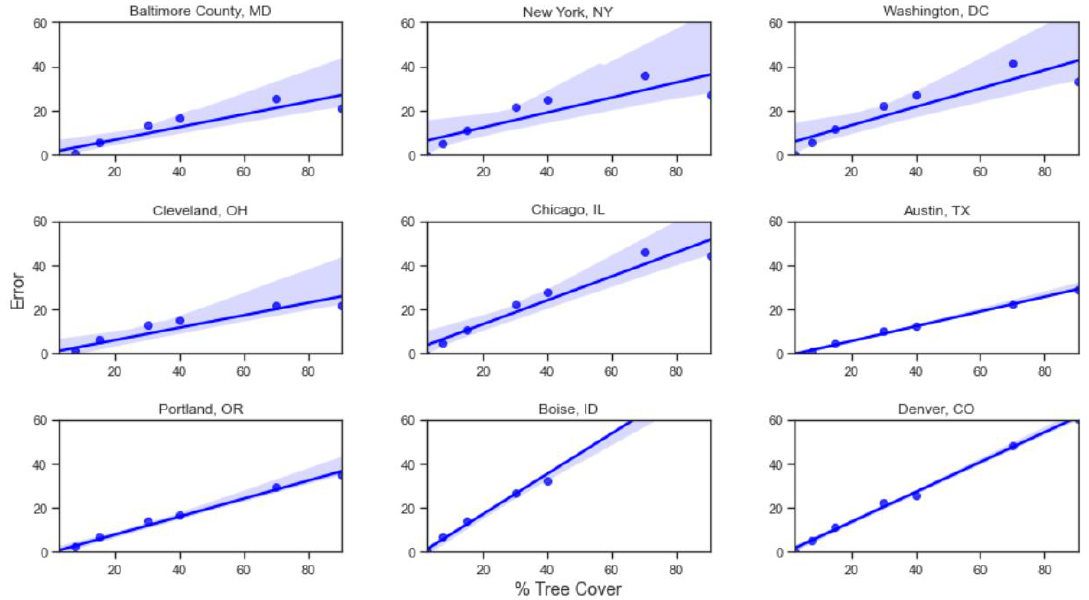
Figure 6. Variations in error (deviation by % when compared to high-resolution derived data) by percent tree cover by city/county. Blue dots show the average of error in each range ([0,5], [5,10], [10,20], [20,40], [20,60], [60,80], [80,100]) and the blue line is the regression line; the shaded area shows the confidence intervals of slopes and intercepts.